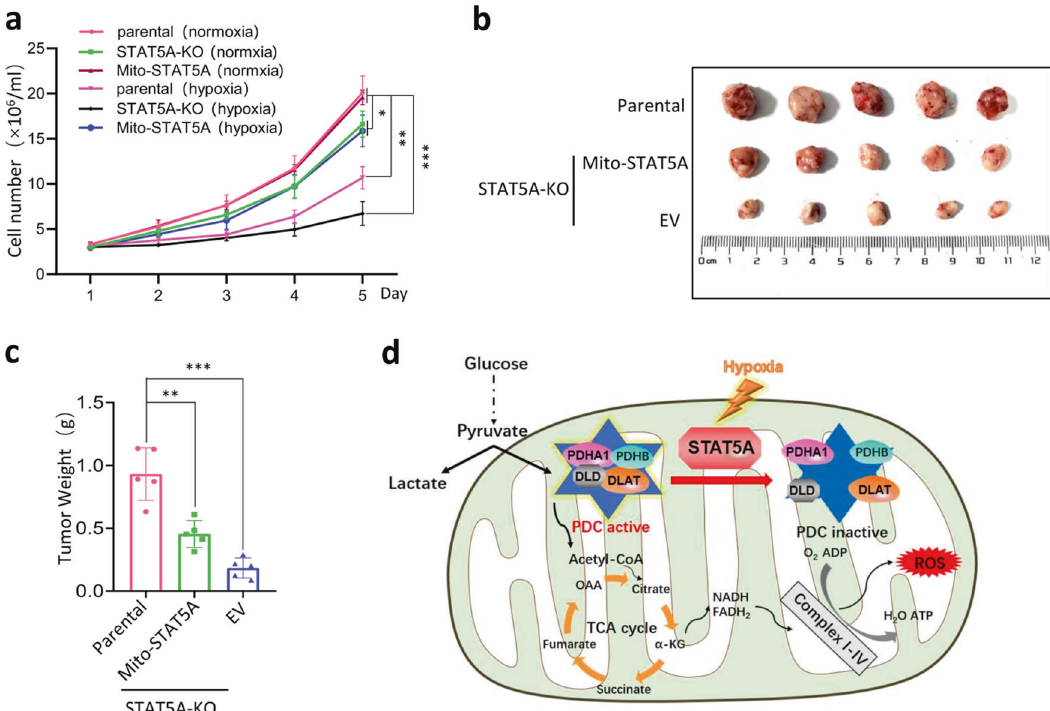
Fig. 6 Mitochondrial STAT5A supports cell proliferation in vitro under hypoxia and tumor growth in vivo. a STAT5A-KO HeLa cells were stably transfected with indicated expression vectors. The cells were under normoxic or hypoxic (1% O 2 ) conditions for indicated days. Parental HeLa cells were used as the control. The cell proliferation analysis was measured by Cell Counting Kit-8 (CCK-8). b , c Parental or STAT5A-KO HeLa cells stably overexpressing EV or Mito-STAT5A were implanted subcutaneously in nude mice. After 3 weeks, the tumors dissected from nude mice were photographed for comparison ( b ). The weight of implanted tumors ( c ). Five mice were used in each group ( n = 5). d A proposed model shows that mitochondrial STAT5A acts as a regulator of PDC activity. For statistical analysis, all data shown are mean values ± SD (error bar) from three independent